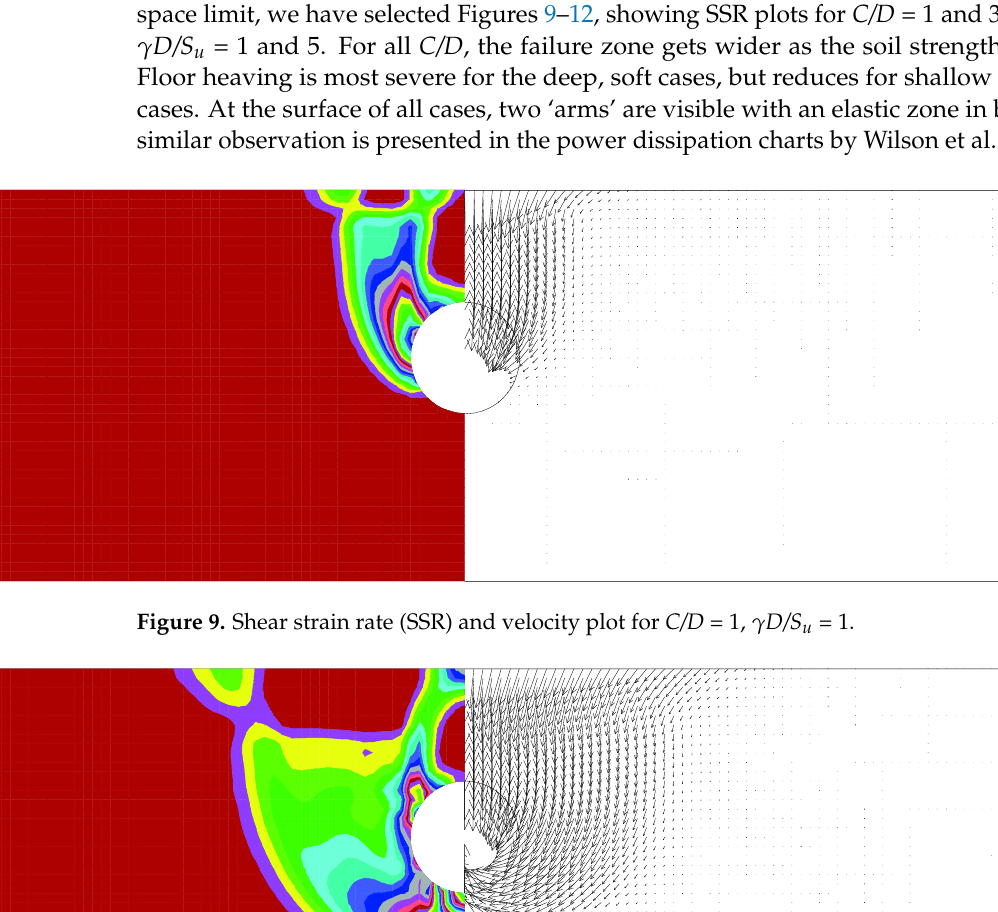
Figure 11. Shear strain rate (SSR) and velocity plot for C/D = 3, γD/S u = 1 . Figure 12. Shear strain rate (SSR) and velocity plot for C/D = 3, γD/S u = 5 . 5. Settlement Results Once the collapse stage has been identified, the surface settlement data can be ex- tracted for that stage. A sample of these settlement profiles are shown in Figures 13–16 for various cases, as labeled. As previously discussed, these settlement profiles are commonly